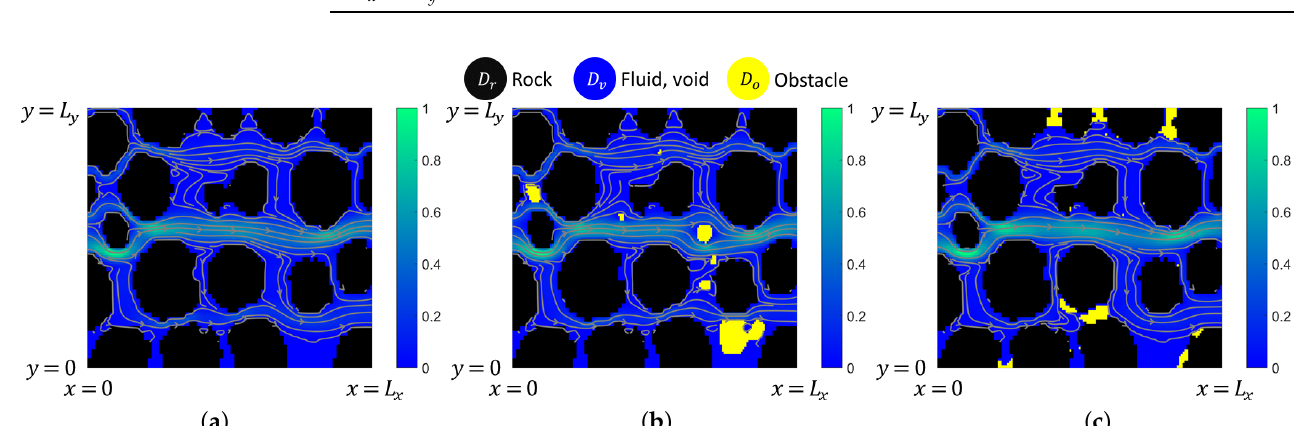
Figure 6. Illustration of flow in Example 1 with M = 152 × 114, ( a ) no obstructions and D v = D f , ( b ) hydrate-like pore- filling obstructions, ( c ) biofilm-like pore-coating obstructions. In ( b – c ) V o = 0.05. Shown are normalized velocity magnitude | u | ( x ) as well as the streamlines. We follow up with calculation of permeabilities and obtain ( a ) K = 6.64 × 10 − 5 [ mm 2 ] , ( b ) K = 5.66 × 10 − 5 [ mm 2 ] , and ( c ) K = 5.87 × 10 − 5 [ mm 2 ]